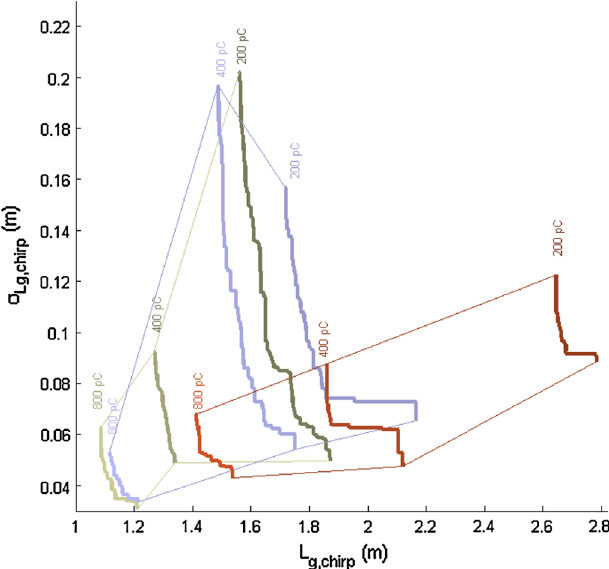
FIG. 7. Comparison of Pareto-optimal fronts for the three linac schemes with one (red), two (lilac), and three (green) bunch compressors at different initial values of